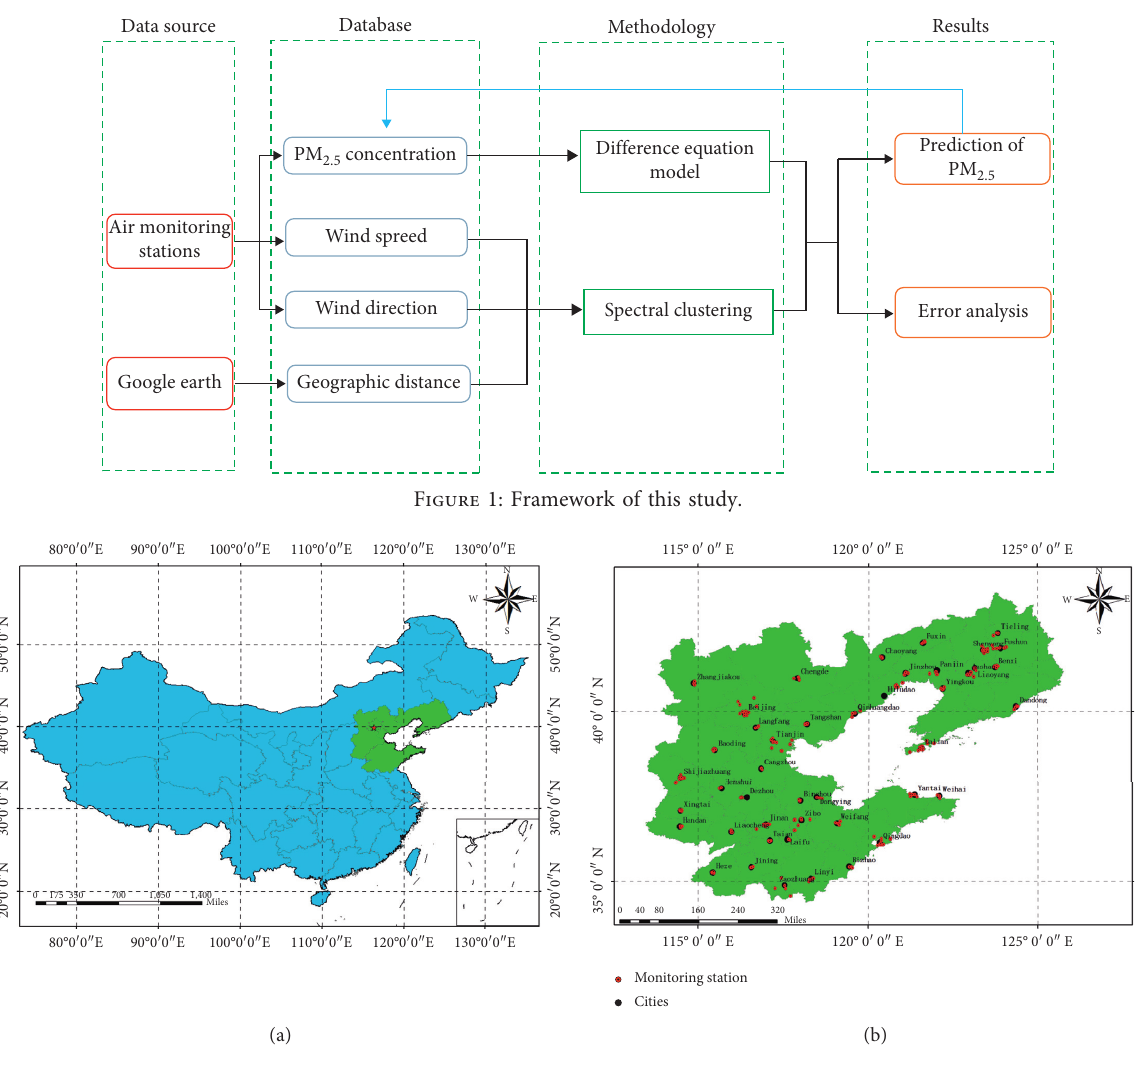
Figure 2: Map of the study area showing the main air monitoring stations.